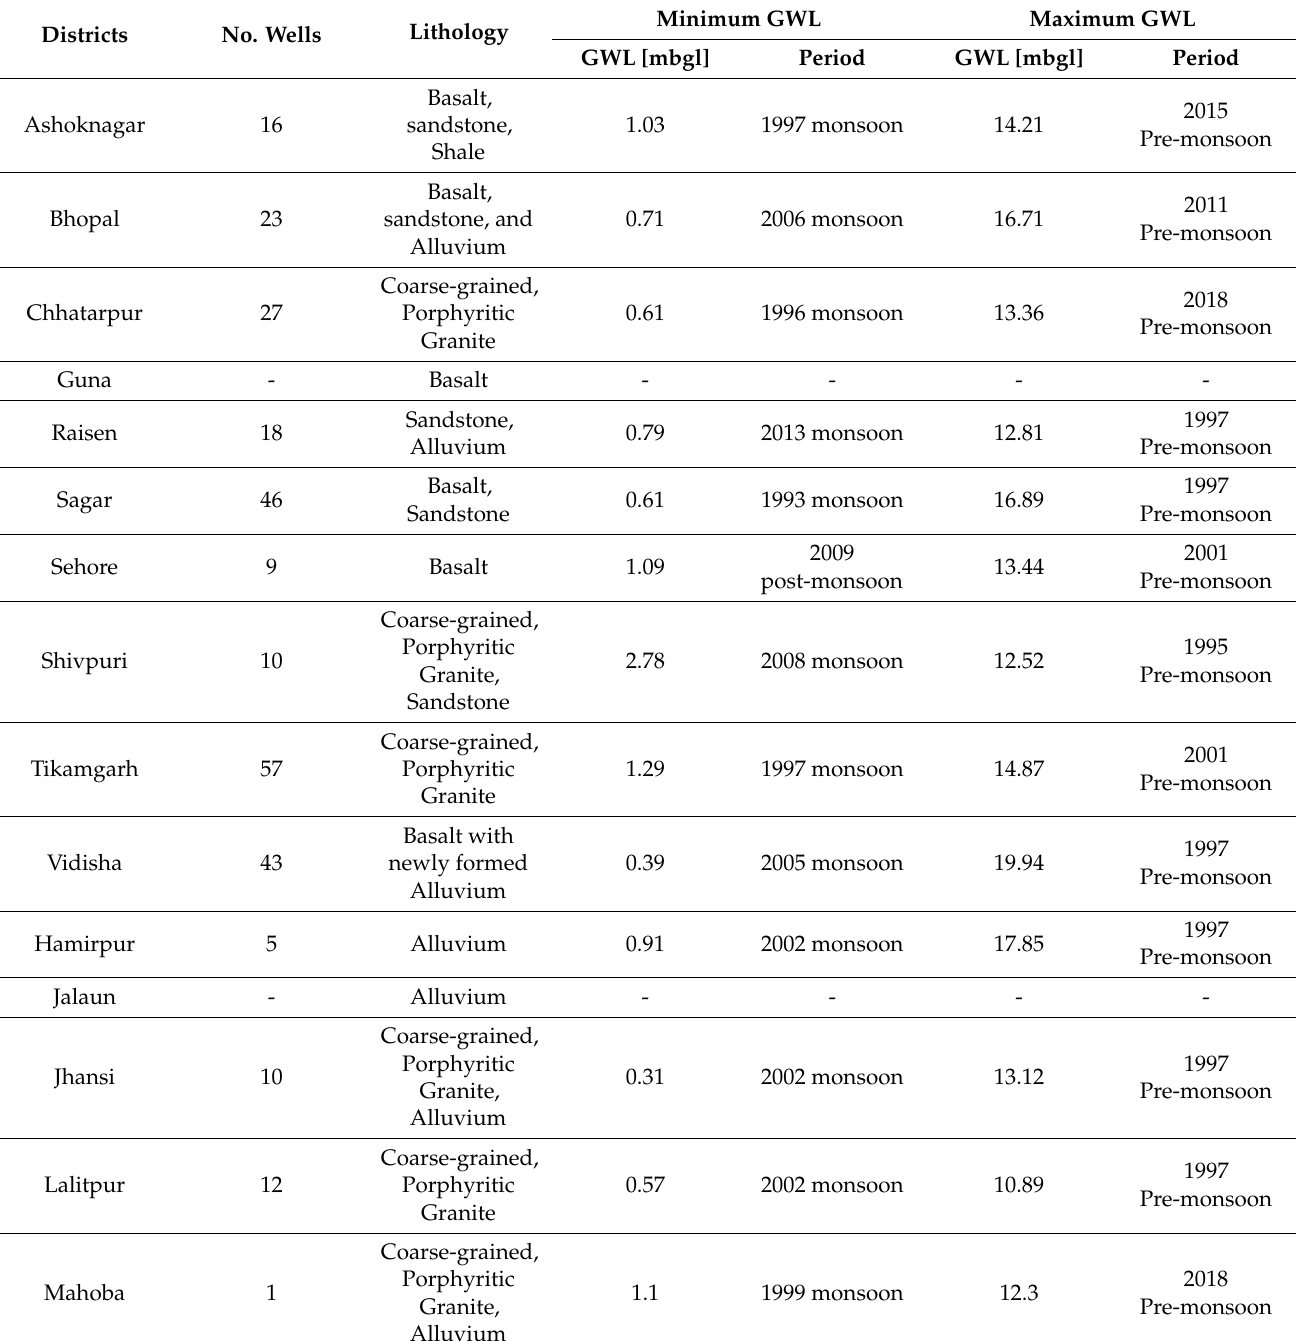
Table 1. District-wise detailed groundwater condition and lithology of the study area (CGWB).